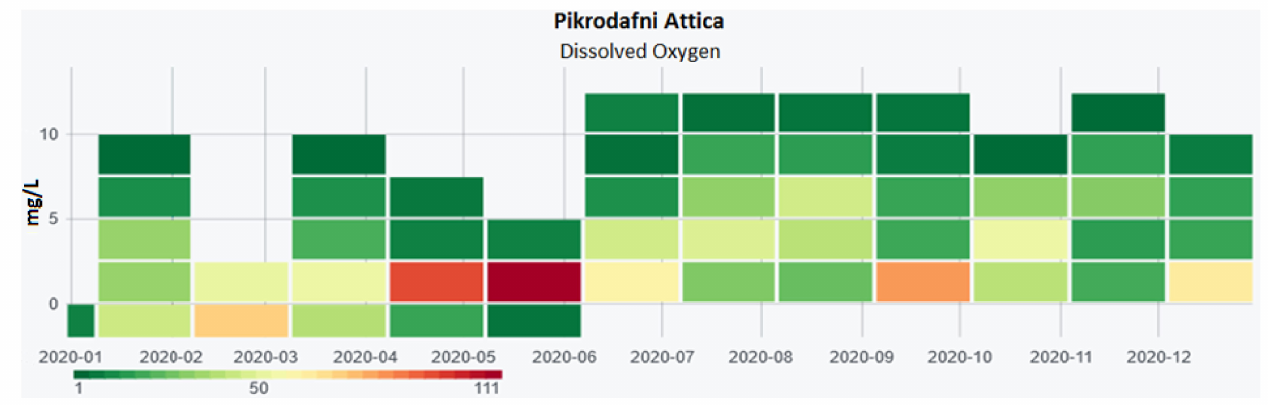
Figure 10. A heat map showing the frequency and variability of dissolved oxygen (DO) values in each month of 2020 at Pikrodafni station.